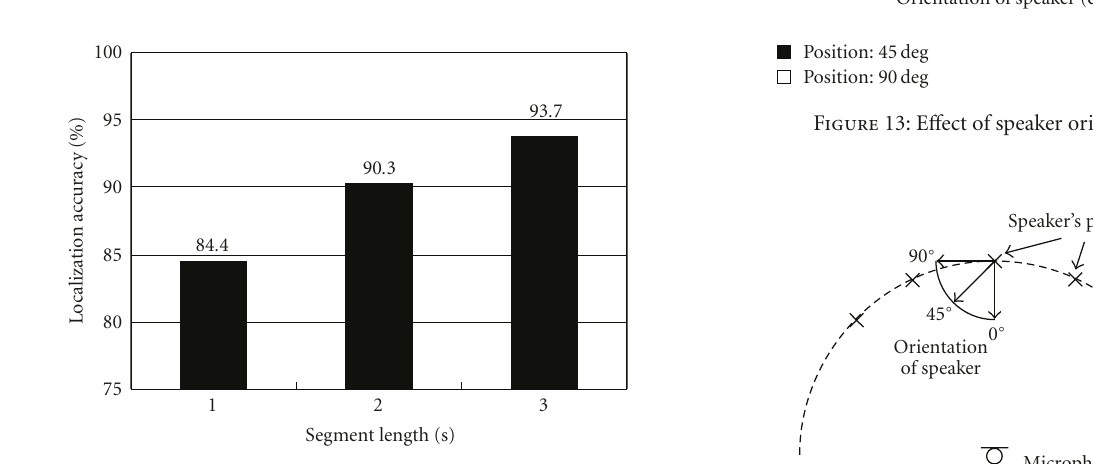
Figure 11: Experiment room environment.